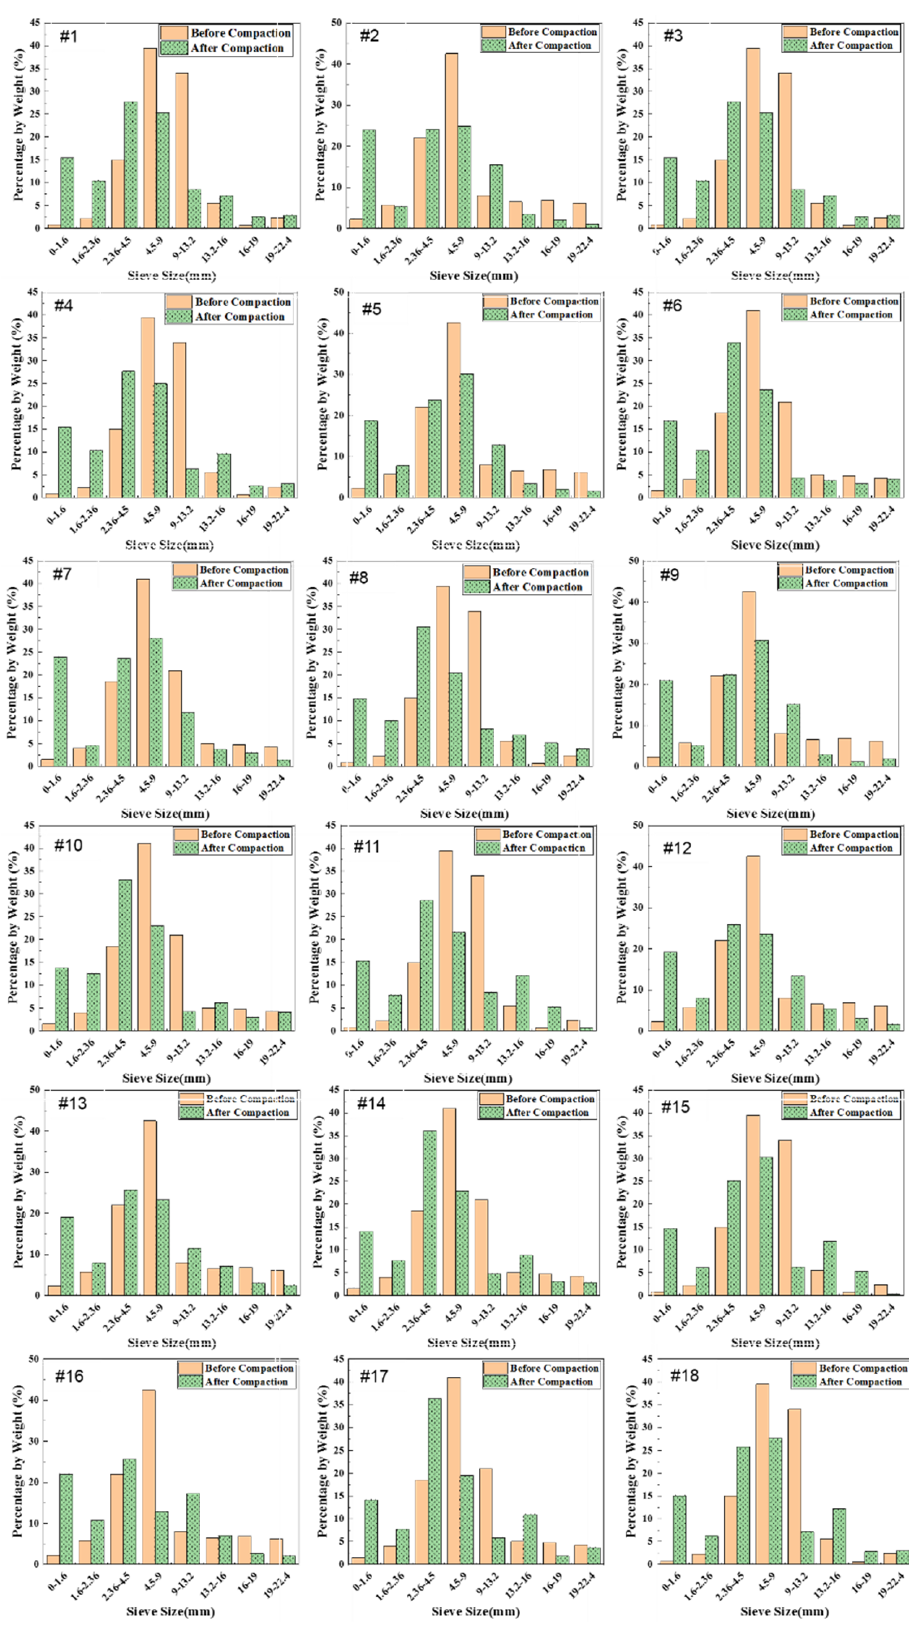
Figure 22. Histograms of particle size distributions before and after gyratory compaction for the eighteen specimens included in the orthogonal array testing matrix.